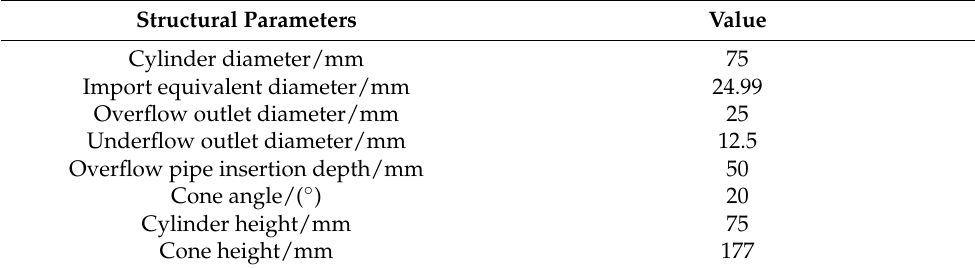
Table 1. Main structural